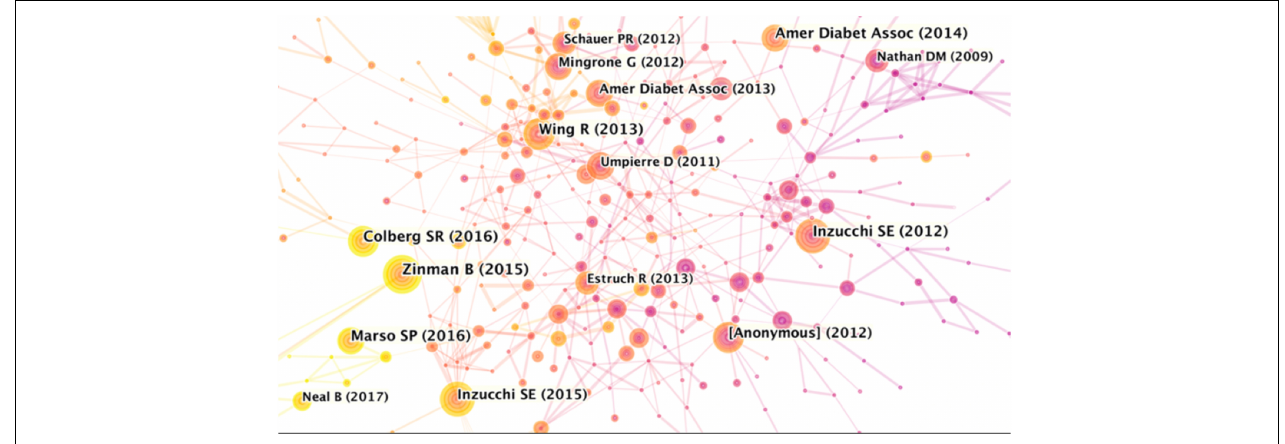
FIGURE 6 | Network map of references contributed to physical activity therapy for diabetes research. Each colored solid circle represents a country/region, and the lines between them represent collaborative relationships.